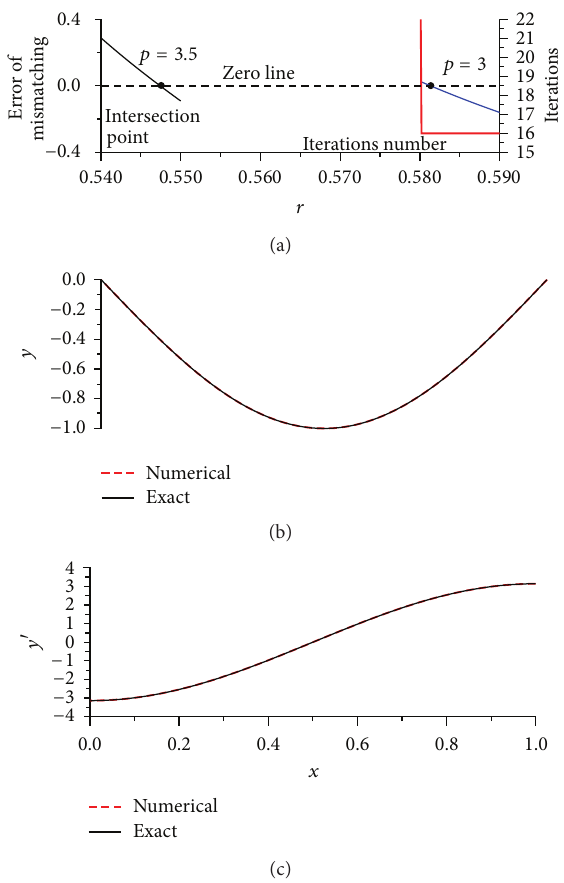
Figure 1: Example 1 solved by the SL (3, R ) method, (a) showing the error of mismatching and iterations number and comparing numerical solutions and exact solutions (b) of 𝑦 and (c) 𝑦 󸀠